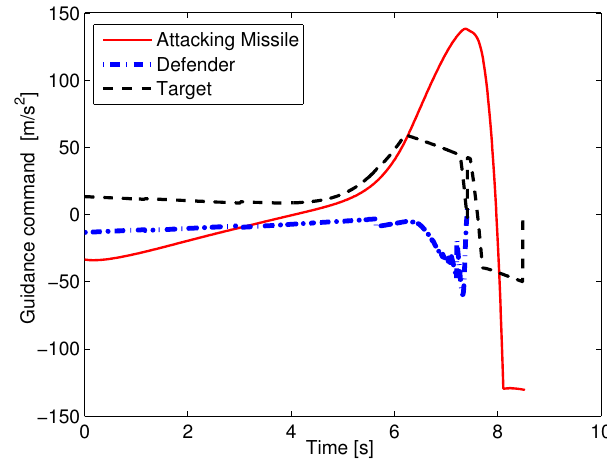
Figure 5. The guidance commands of three aircraft in the case of [ γ M 0 , γ T 0 , γ D 0 ] = [ 20 ◦ ,25 ◦ ,30 ◦ ]